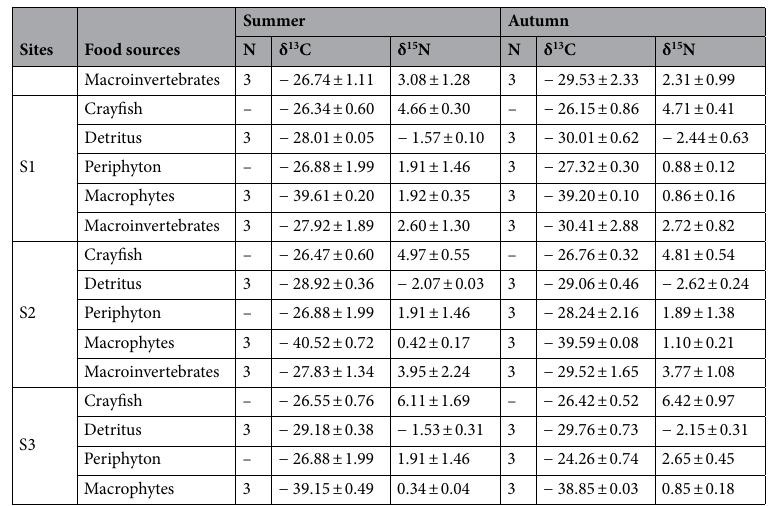
Table 2. Mean (± SD) stable isotope values of carbon and nitrogen of food sources at each site in Valla Stream in summer and